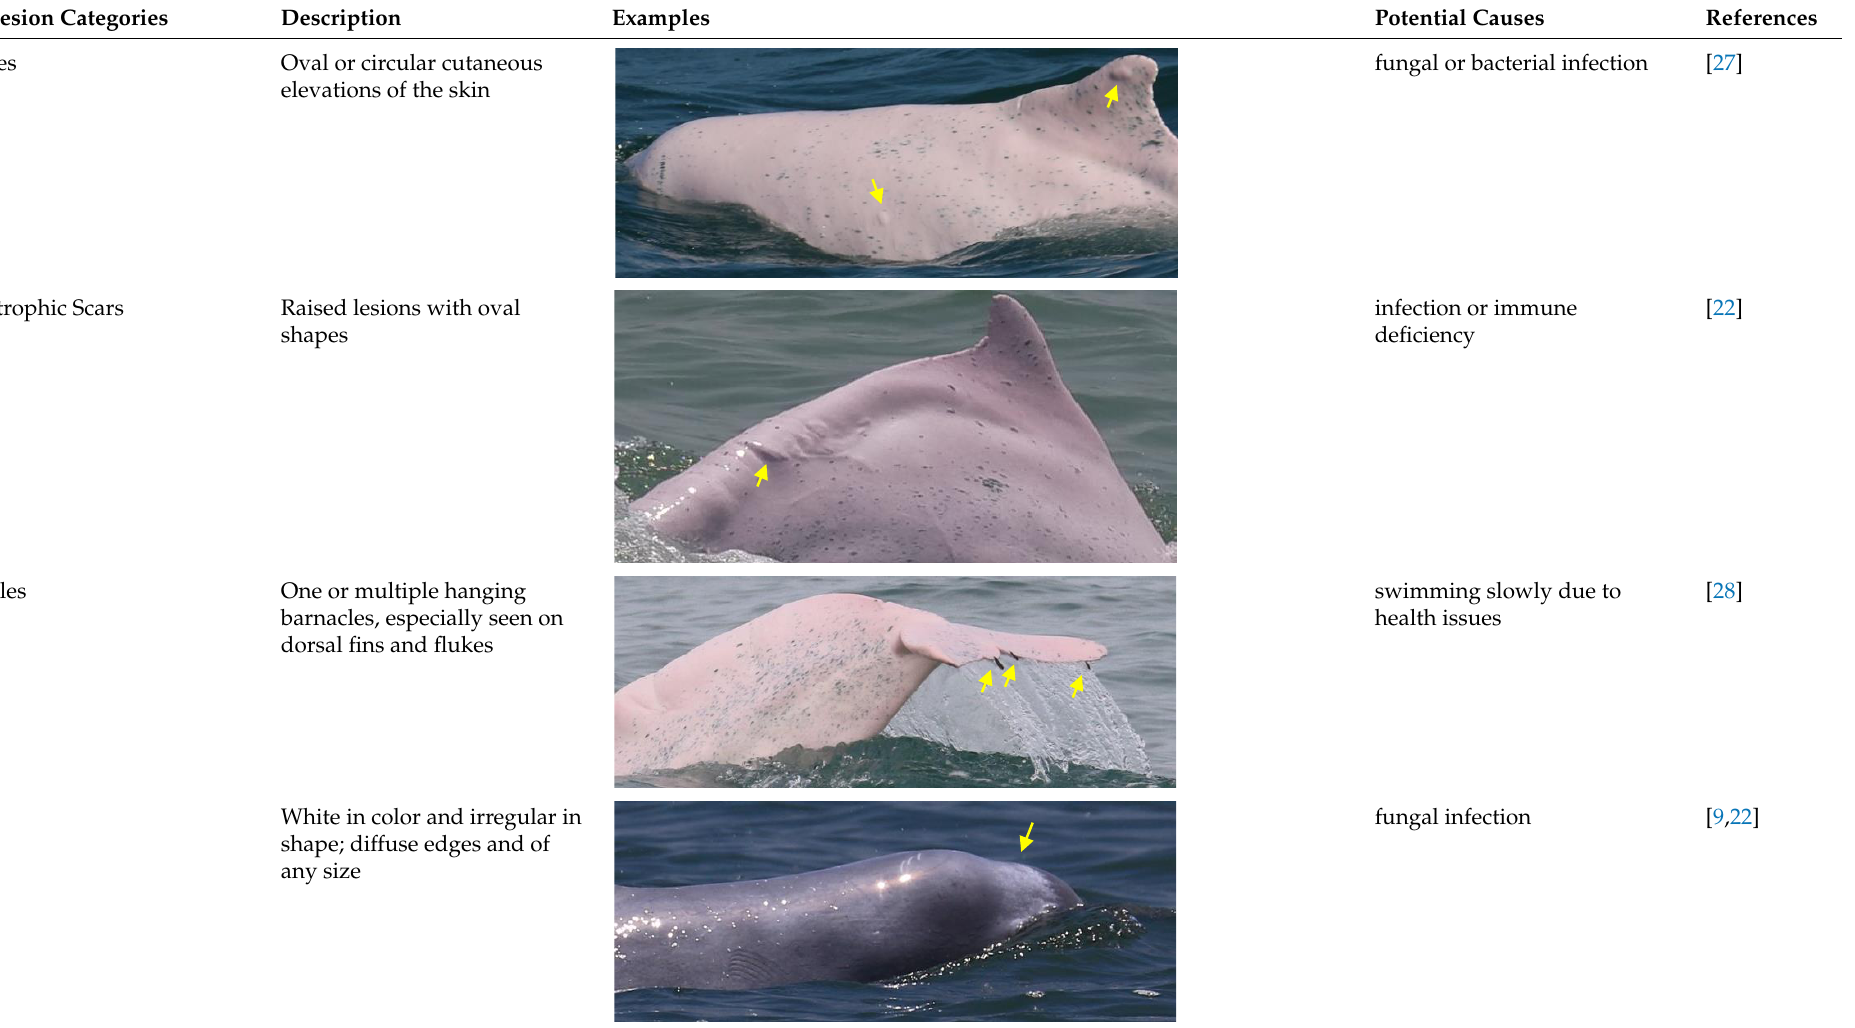
Table 2. Definitions of skin lesion (arrows and circles) categories and potential causes.